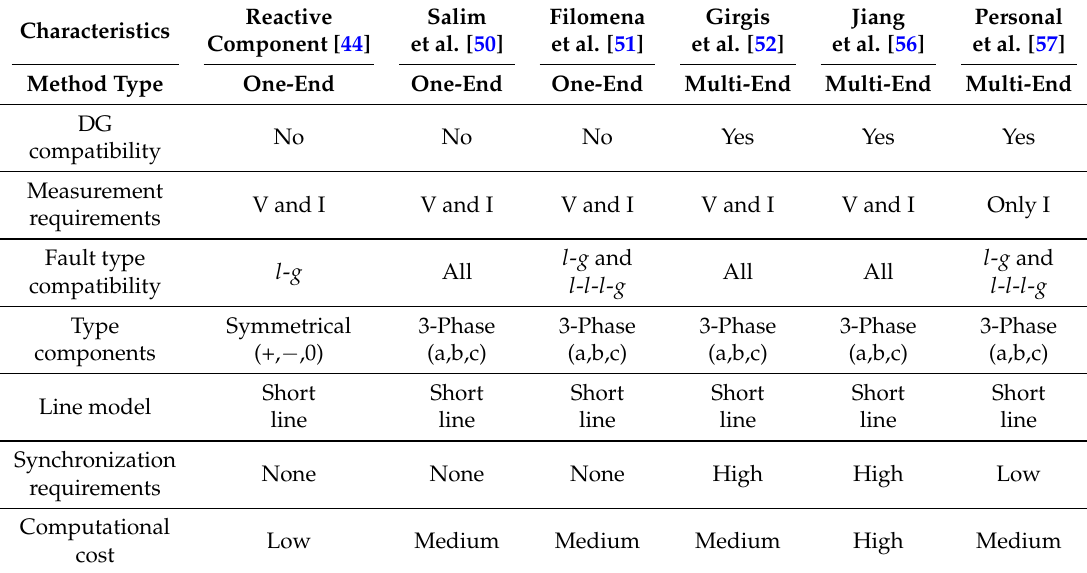
Table 1. Summary of the characteristics of the compared